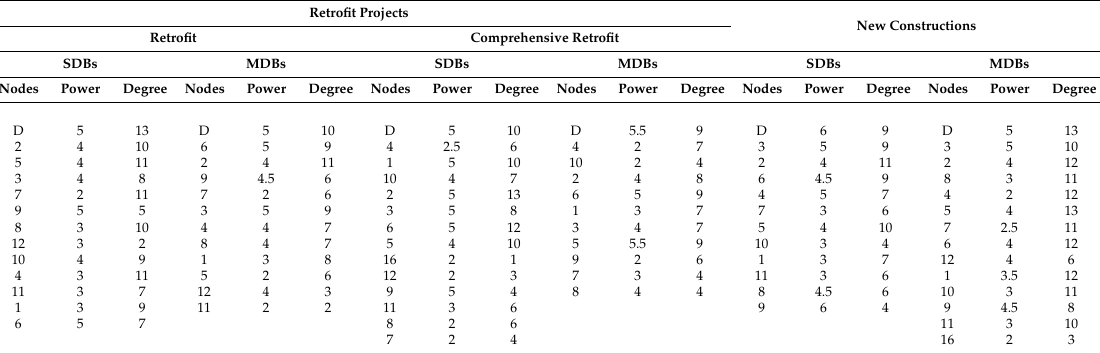
Table A8. Numerical output stakeholder networks classified according to building typologies and project types in Belgium (BE).